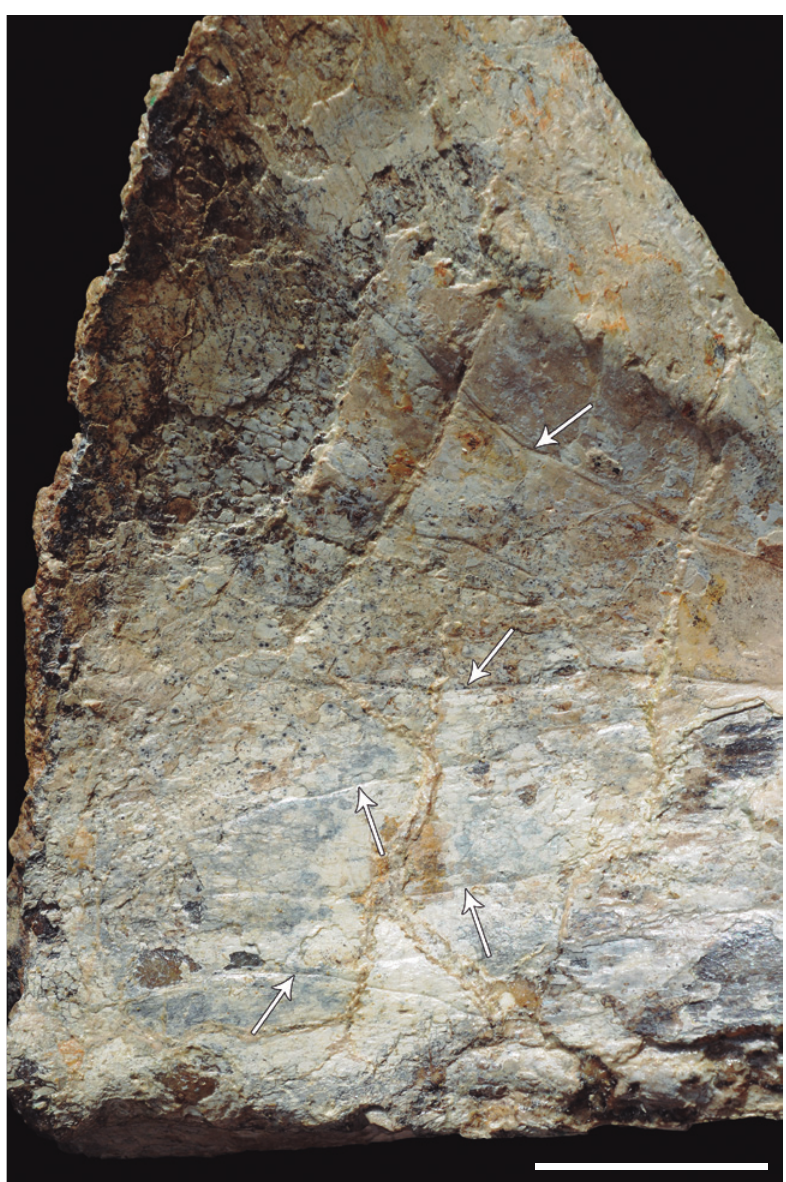
Fig. 3 - Incomplete rostrum of Tropeognathus cf. T. mesembrinus (MN 6594-V) in left lateral view. Arrows indicate channels, regarded as impressions of blood vessels. Scale bar 50